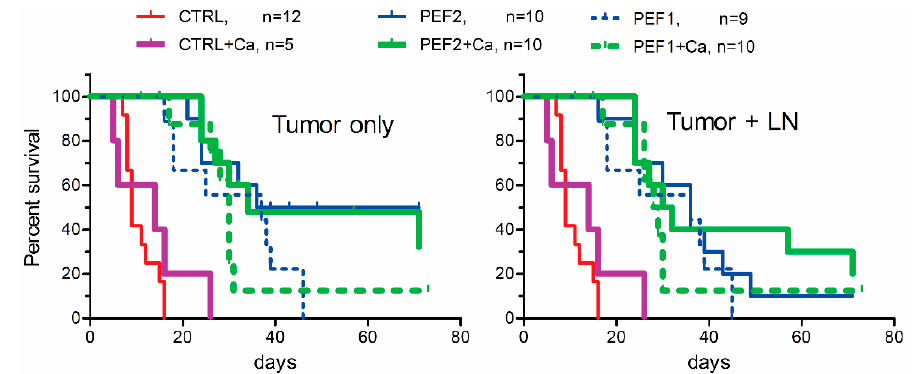
Figure 4. Kaplan-Meier survival curves of mice with SP2/0-luc tumors treated with pulsed electric field (PEF) or PEF + Ca. The endpoint in survival curves was taken at the time when the volume of the primary tumor (left) or the sum of primary tumor and enlarged lymph nodes (LN) due to metastasis (right) reached 3000 mm 3 . CTRL (not treated tumor bearing mice), CTRL + Ca (mice treated with calcium alone) PEF1 (12 kV/cm × 200 ns × 500); PEF2 (12 kV/cm × 500 ns × 500), PEF1 + Ca and